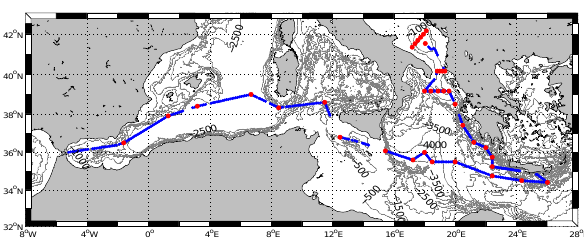
Figure 1. Cruise track of P468 with CTD stations marked in red and UCTD stations marked in blue.